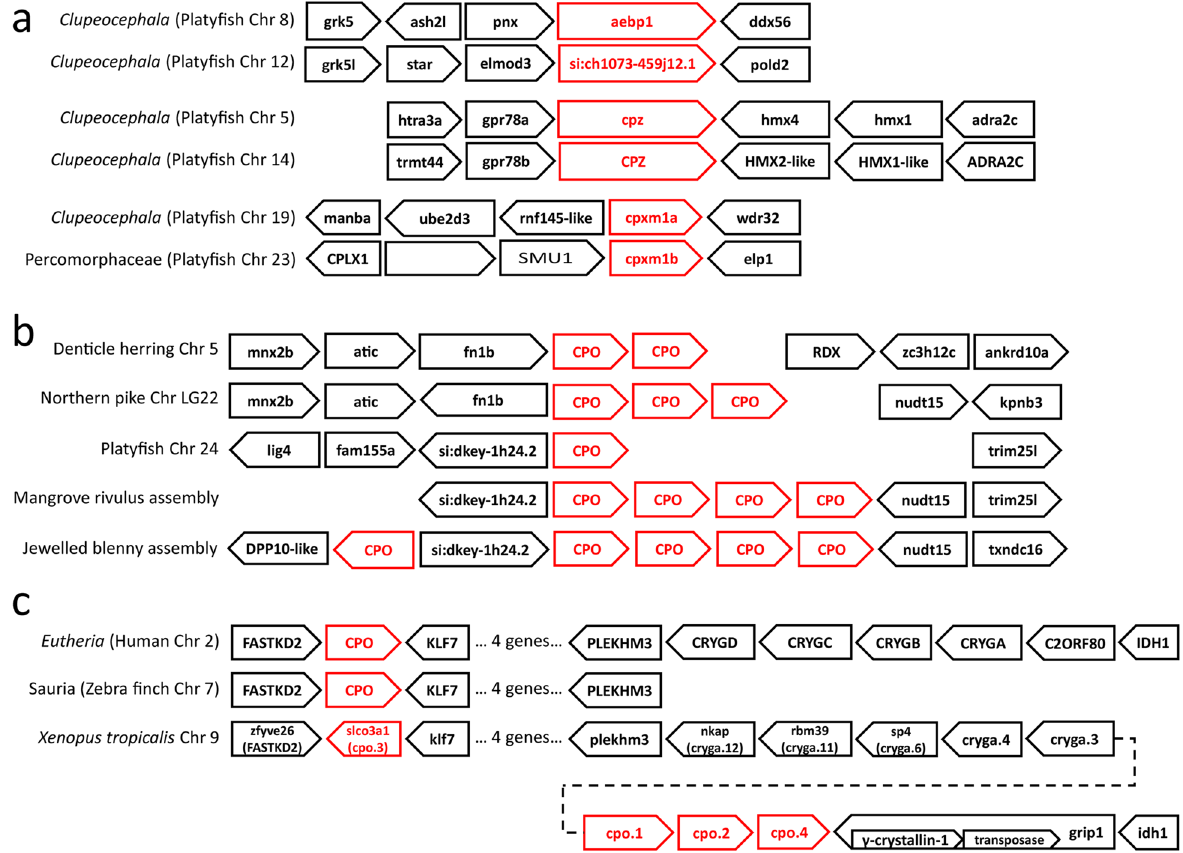
Figure 3. Gene synteny suggests that tandem CPO duplicates were formed through unequal crossing over. Gene synteny information was collected from Ensembl. ( a ) Aebp1, CPZ, and cpxm1 gene paralogs were found on different chromosomes within large blocks of common genes, suggesting a largescale duplication event. ( b ) CPO gene paralogs were always found in tandem, suggesting unequal crossing-over errors. ( c ) CPO gene paralogs in Xenopus tropicalis were found within a gamma crystallin gene cluster and just upstream of a transposase-like